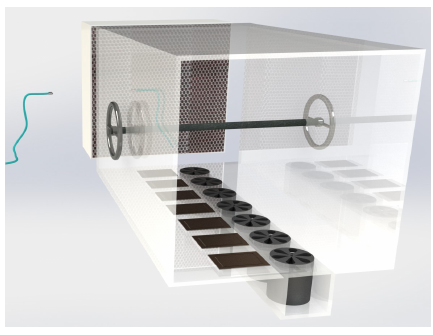
Figure 5. Schematic diagram of experiment setup.